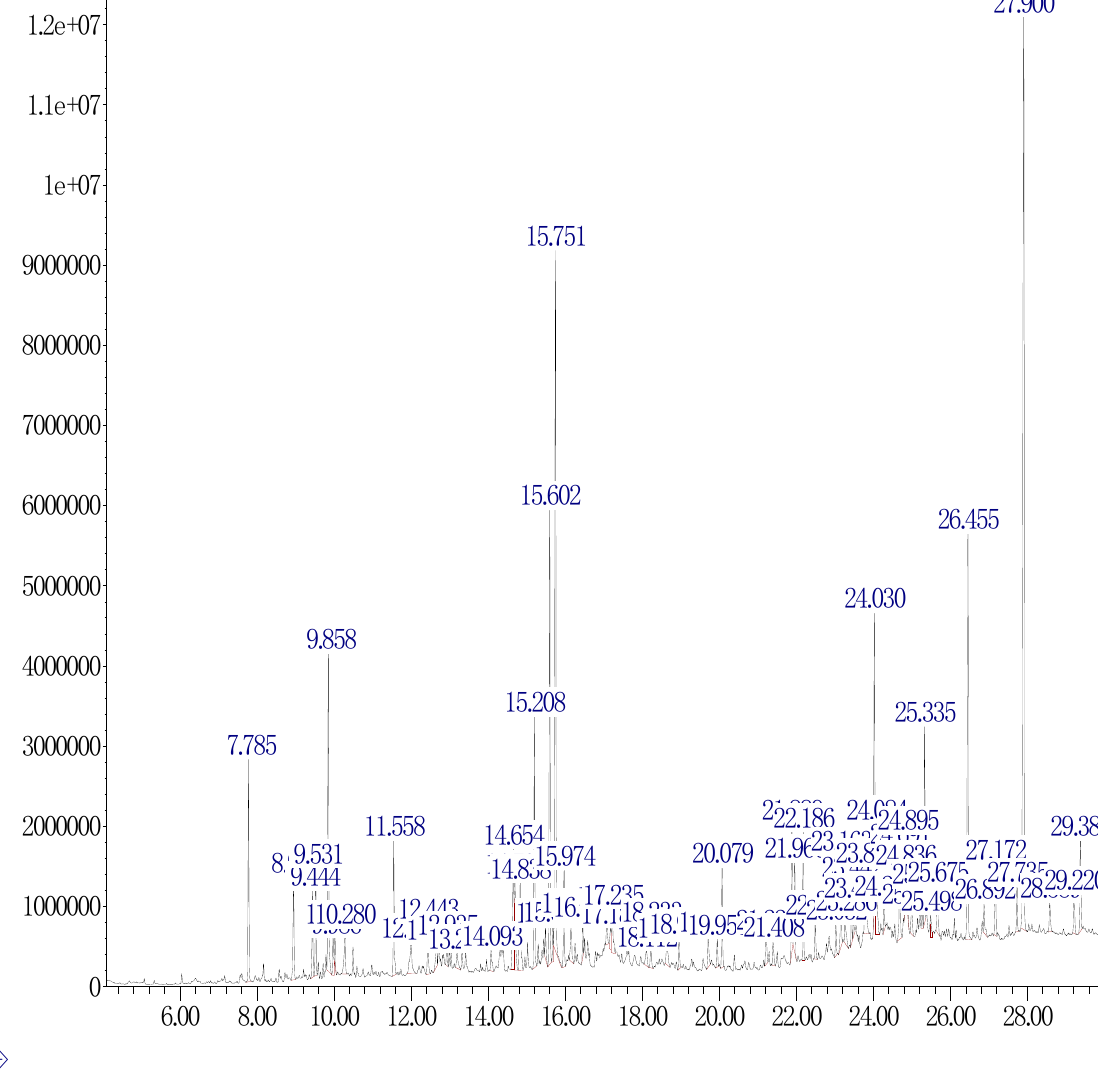
Figure 6. Chromatogram of the characterized ethanolic extract of C. ladanifer.